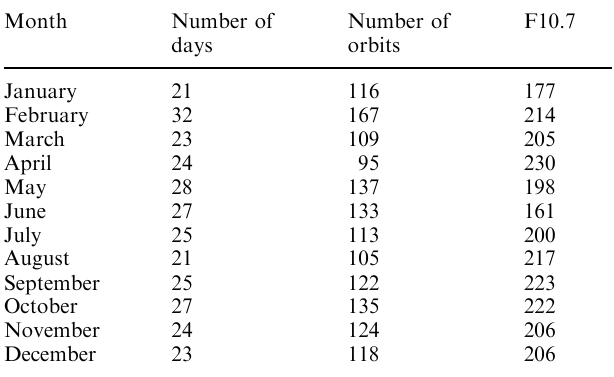
Table 1. Number of days and orbits in which the data are available and the monthly-averaged F10.7 for each month